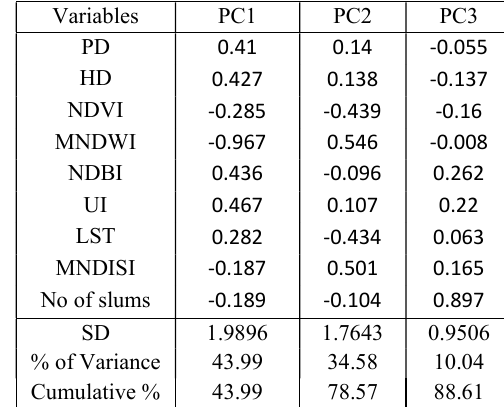
Table 2. Component scores for the indicators used and